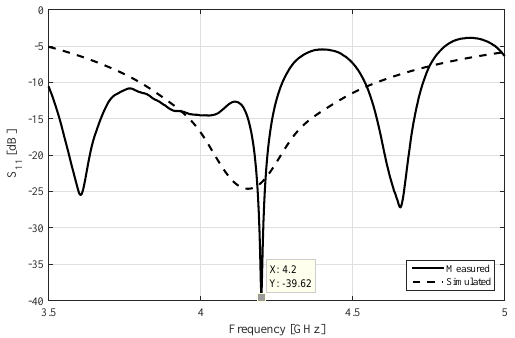
Figure 1: Comparison between the simulated and measured